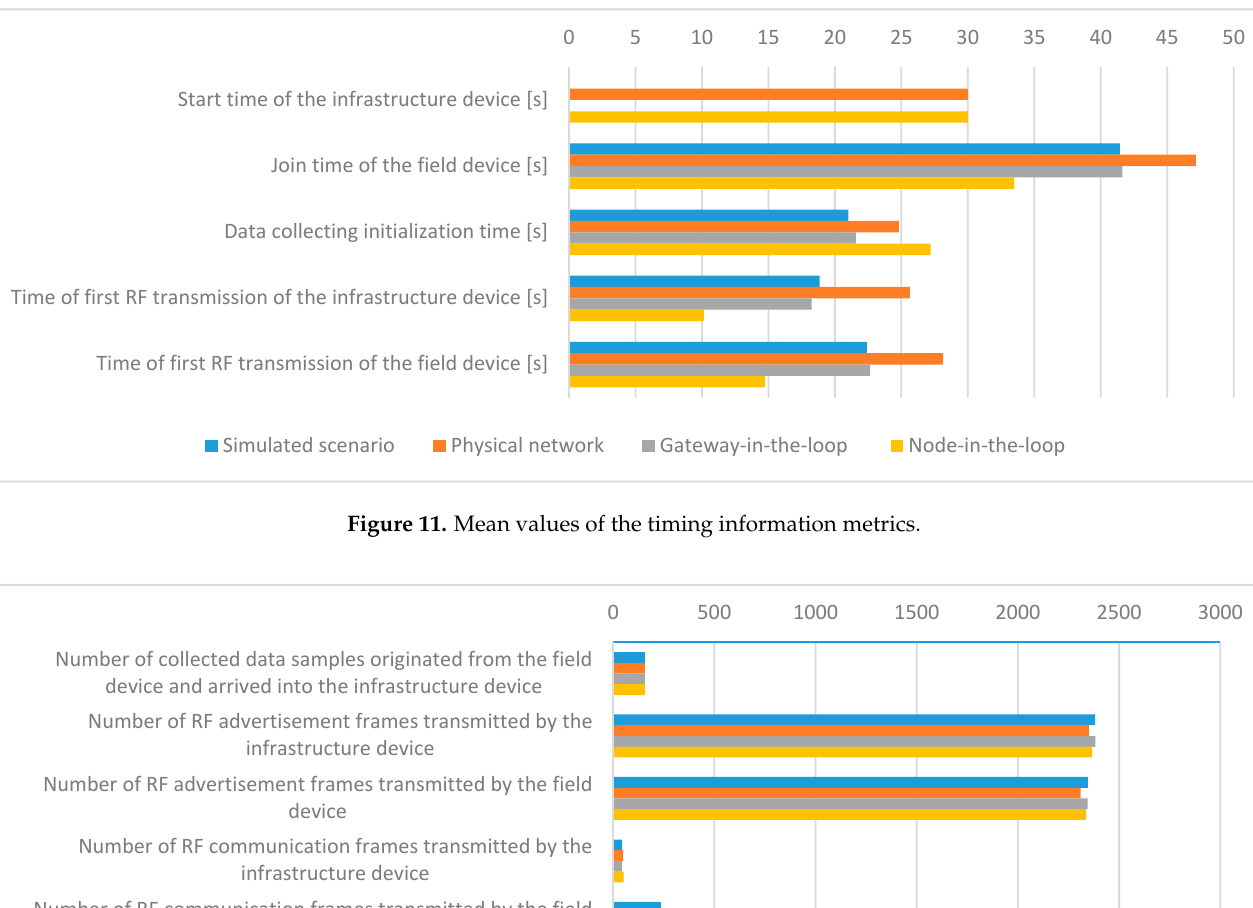
Figure 10. Summary of field device joining to application messages sequence in an ISA100.11a IWSN. The mean values of the evaluated metrics related to the timing information for all scenarios are presented in Figure 11.